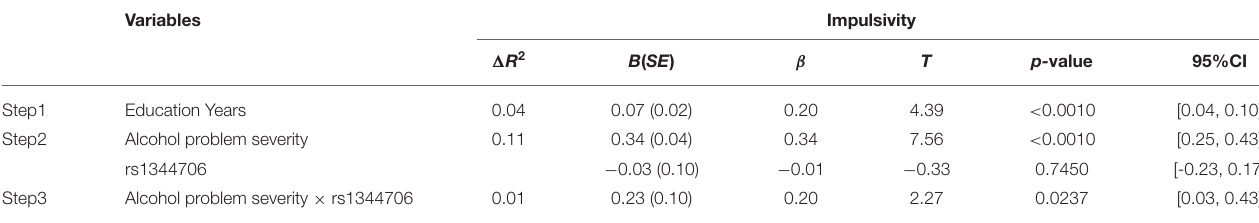
TABLE 5 | Interaction between rs1344706 and Alcohol problem severity on impulsivity.